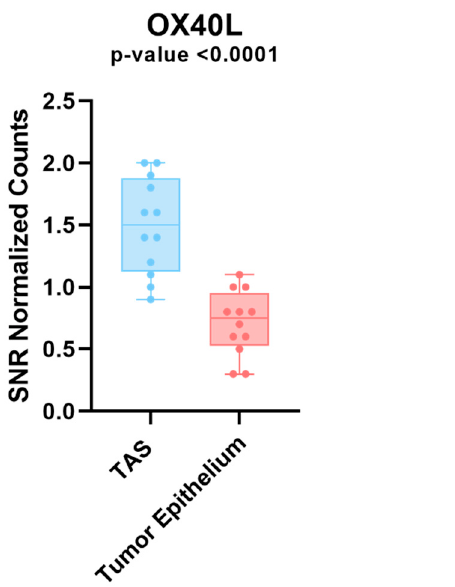
Figure 4. Kaplan–Meier survival analysis of CTLA4 and OX40L in tumor and tumor-adjacent stroma. Comparisons include high and low expression of CTLA4 ( A ) and OX40L ( B ). Quantized percent positivity from a series of TMA cores (n = 1547) was calculated using QuPath. Using a